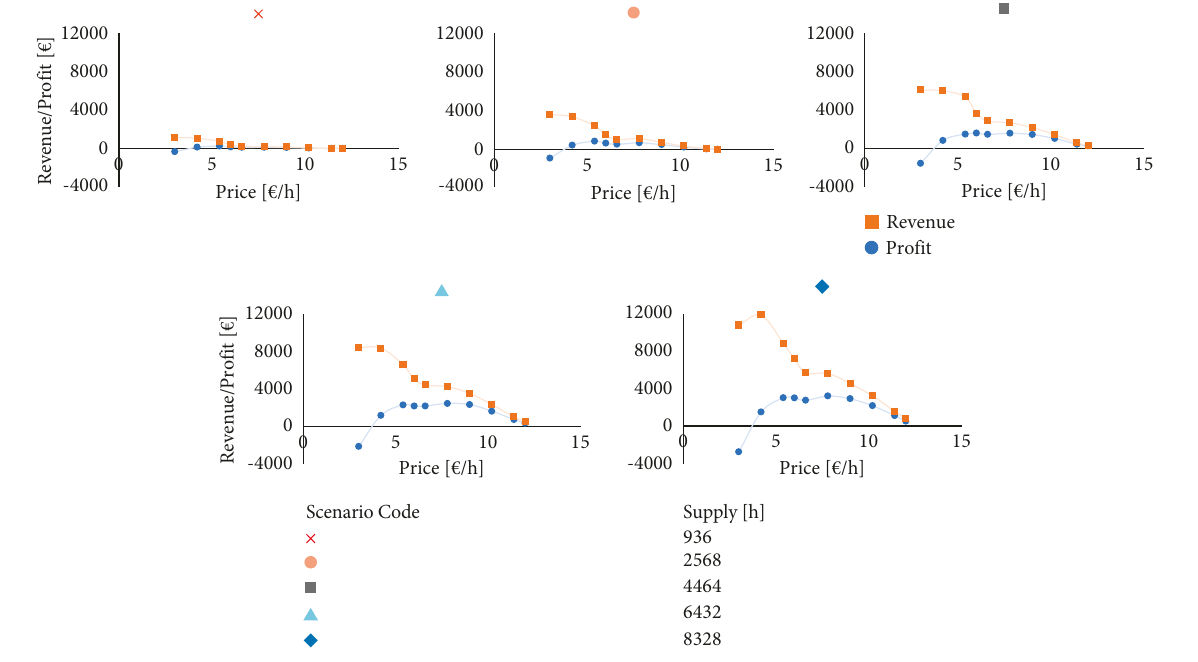
Figure 8: Revenue and profit by supply variation.